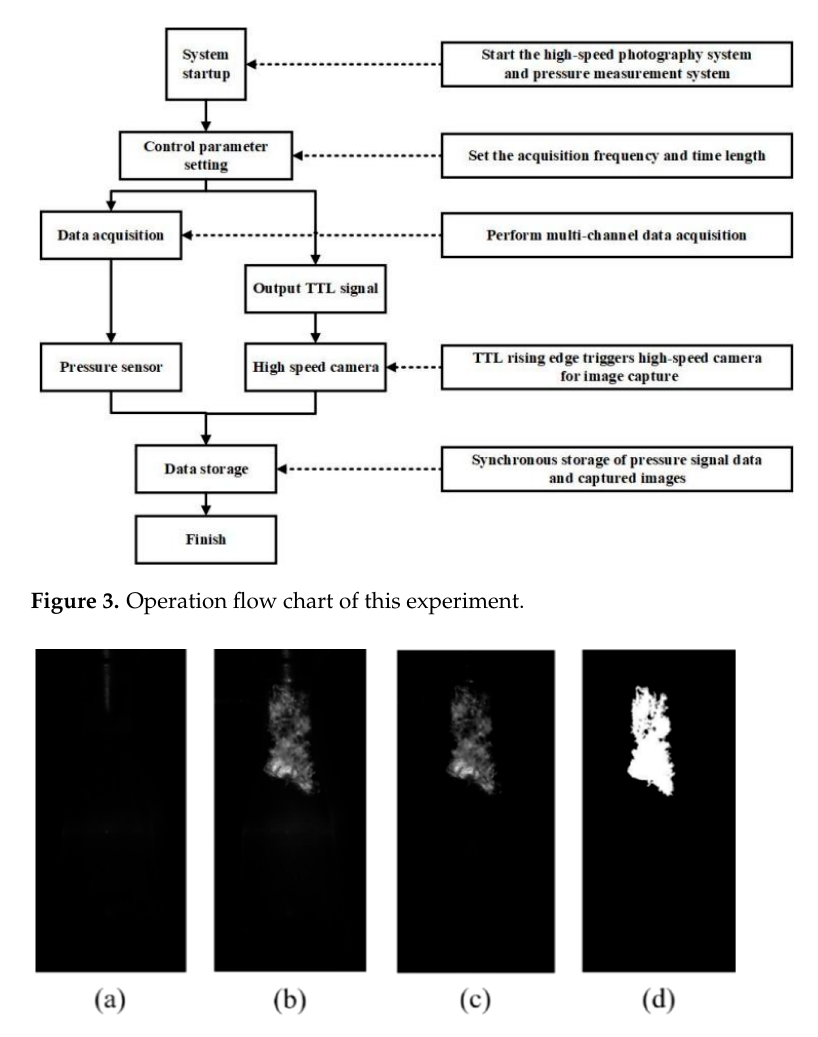
Figure 4. Calculation method of cavity area: ( a ) Original image without cavitation bubble. ( b ) Original image with cavitation bubble. ( c ) The image of cavitation flow. ( d ) The gray value of cavity area.